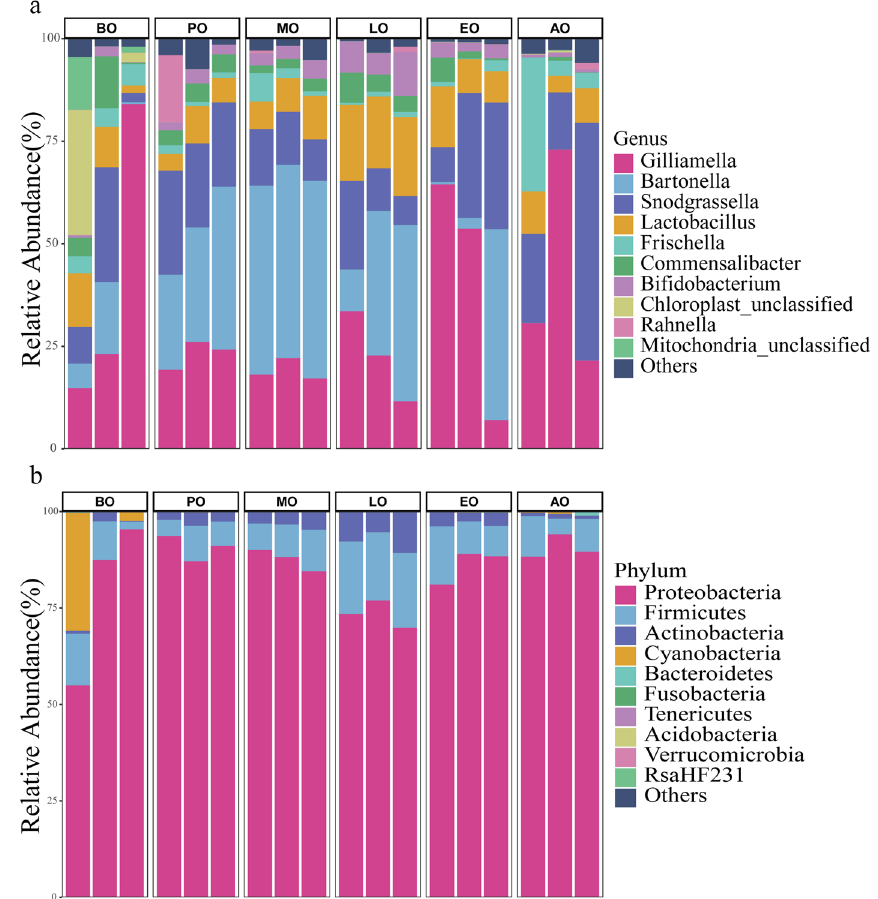
Figure 2. Relative abundance of the dominant gut bacterial communities. ( a ) Relative abundance of the dominant gut bacterial communities in honeybees at the phylum level. ( b ) Relative abundance of the dominant gut bacterial communities in honeybees at the genus level. Each bar represents the average relative abundance of each bacterial taxon within a group. The lowest color block of the column represents the highest abundance (biological repeat mean) of microorganisms in all